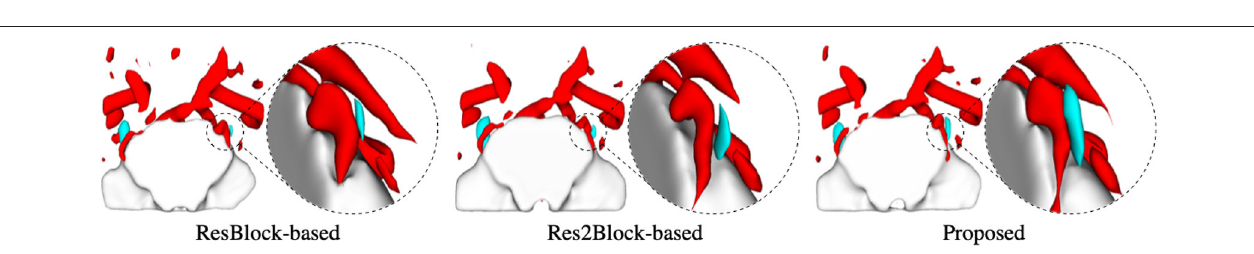
FIGURE 6 | Local enlarge rendering of the trigeminal nerve in the right root entry